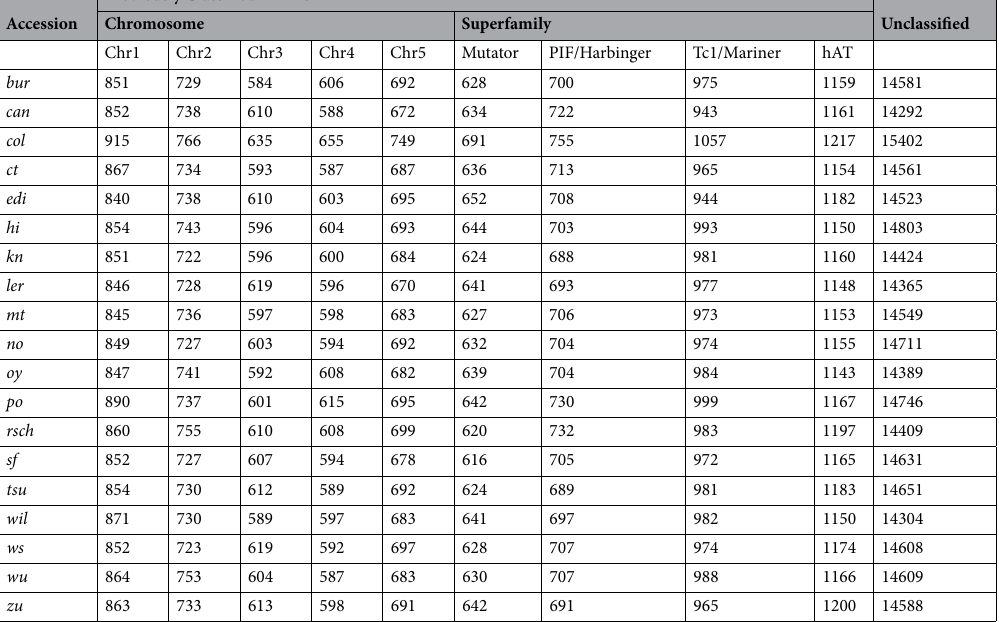
Table 1. Summary of MITEs in all 19 accessions.